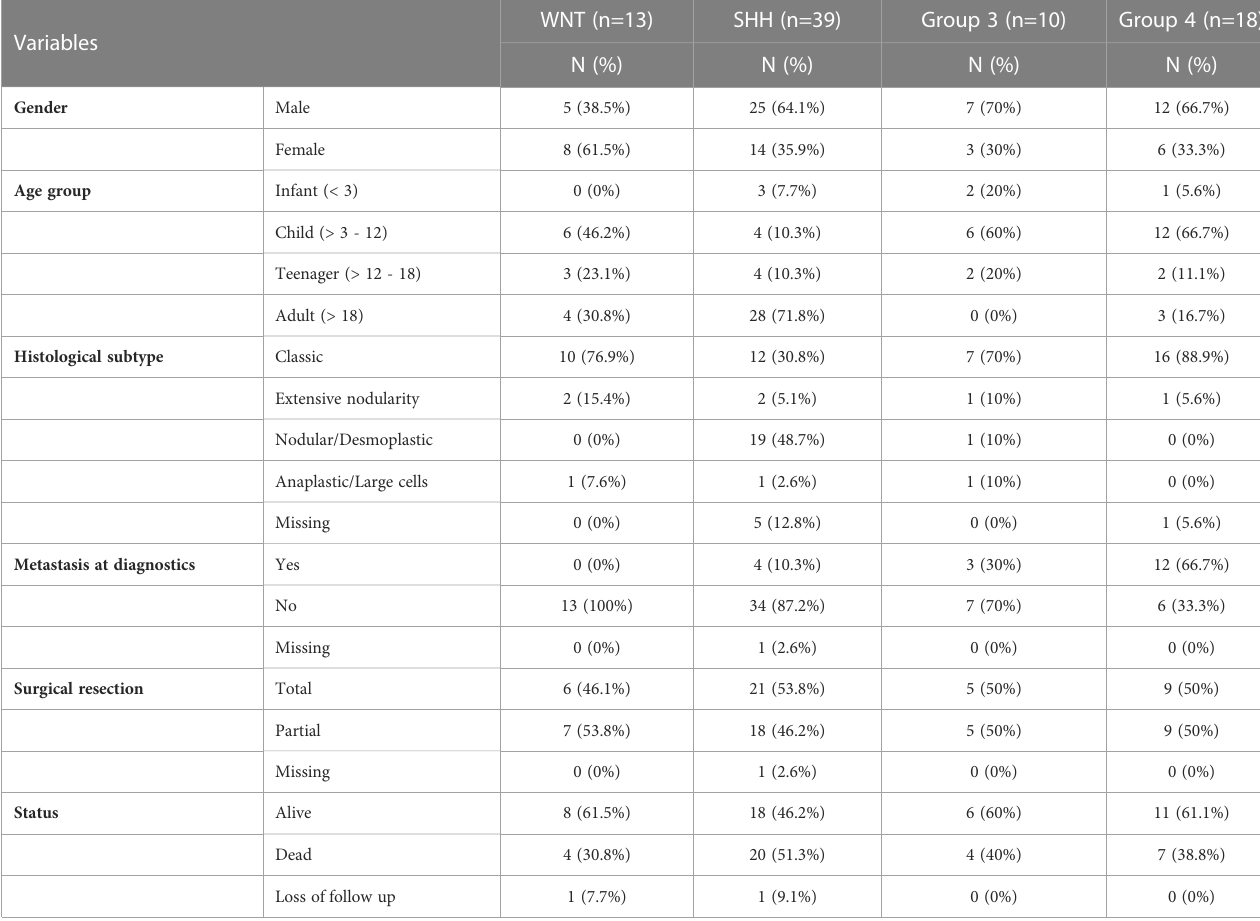
TABLE 1 Clinicopathological features of the 80 Brazilian medulloblastomas.